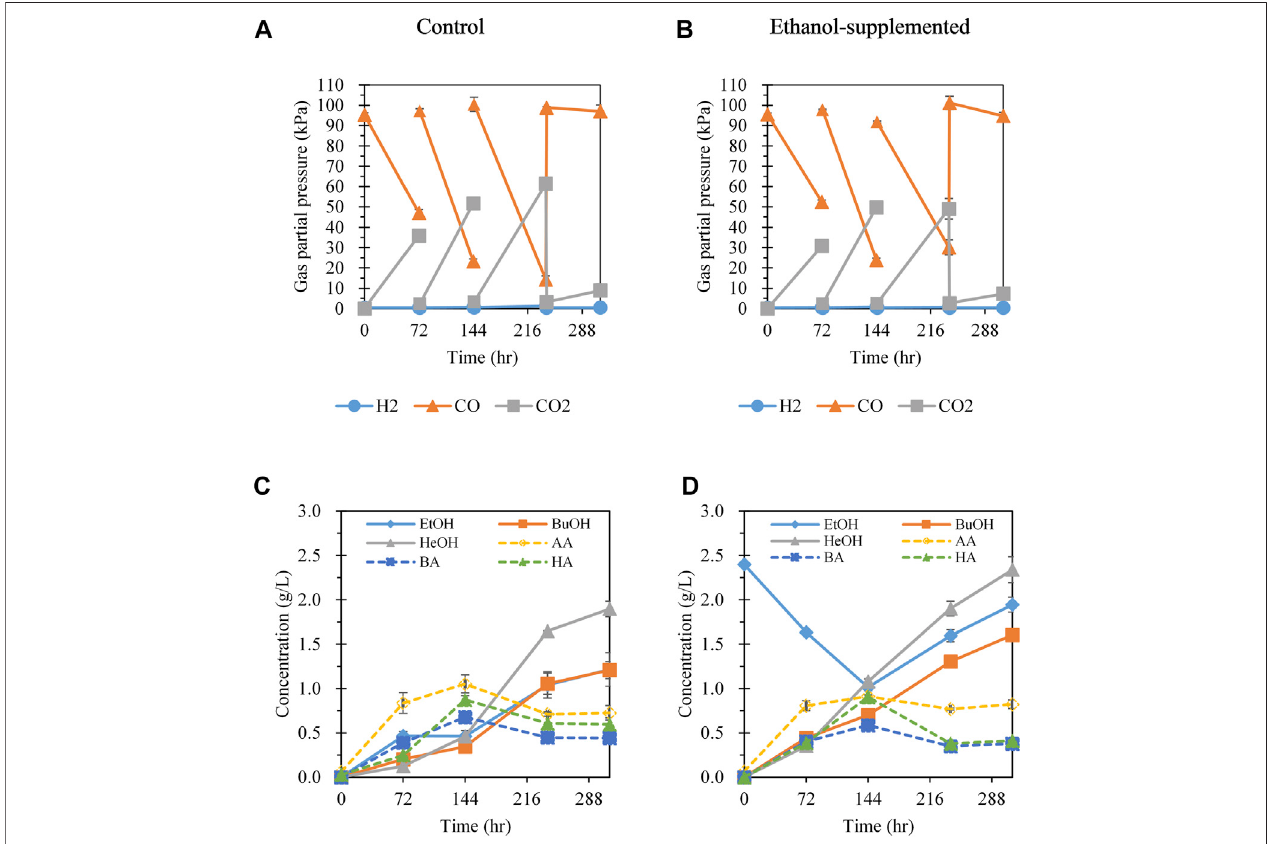
FIGURE 3 | Effect of 70% CO gas refeeding and addition of ethanol on gas consumption and metabolite production. (A) Gas pressure pro fi les with CO gas refeedingat72,144,and240 h; (B) gaspressurepro fi leswithinitialadditionofethanol(2 g/L)andCOgasrefeedingat72,144,and240 h; (C) productpro fi leswithgas refeeding; (D) products pro fi les with ethanol addition and gas refeeding. Each data point and error bar represents the average and range of duplicate experiments, respectively. EtOH, ethanol; BuOH, butanol; HeOH, hexanol; AA, acetic acid; BA, butyric acid; HA, hexanoic acid.